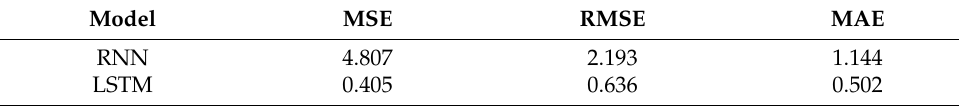
Table 1. Comparison of prediction performance between LSTM and RNN.